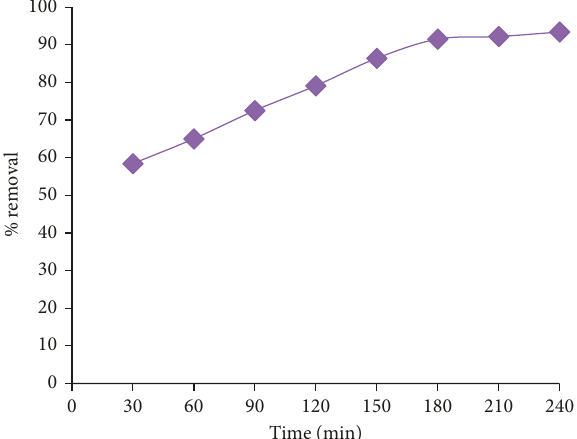
Figure 8: Effect of contact time on adsorption of lead.